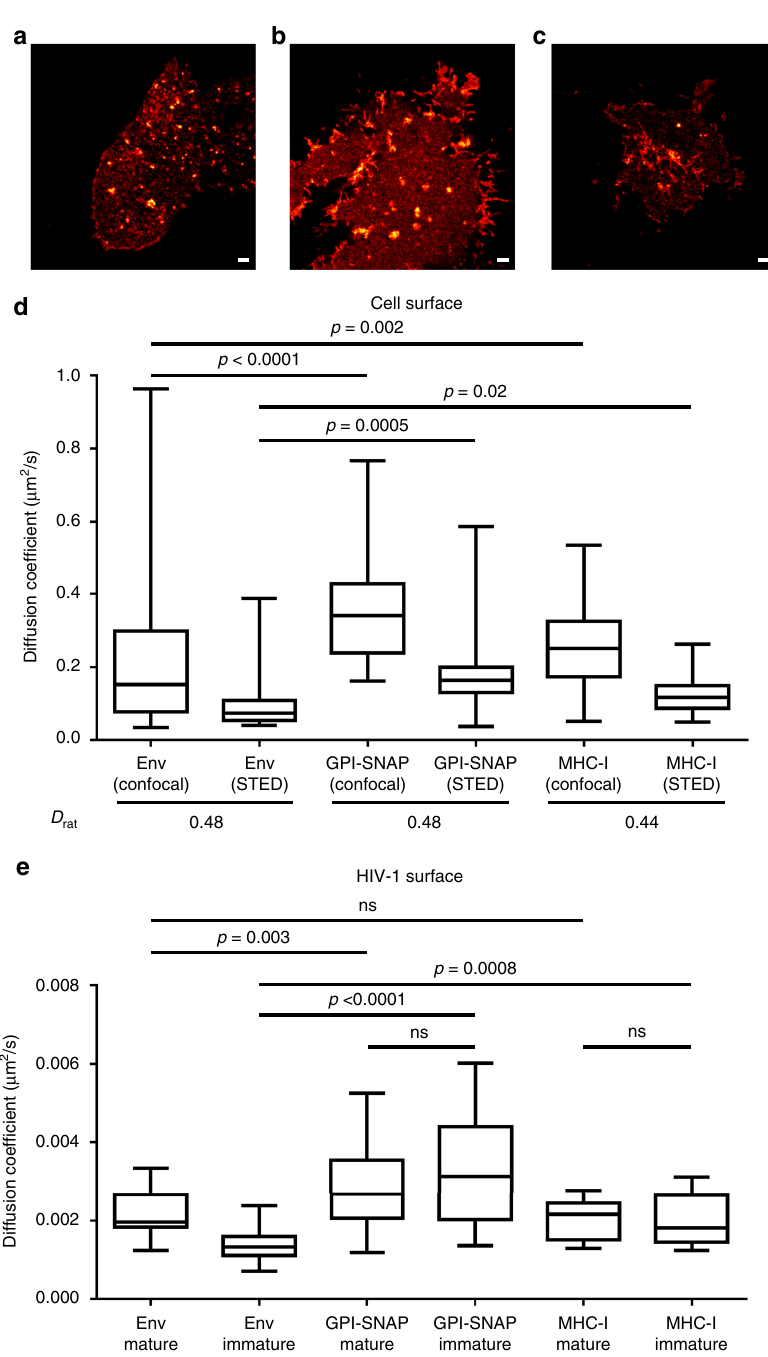
Fig. 4 Comparison of protein molecular dynamics in cell and virus membranes. a – c Live confocal images of 293T cells expressing Env a and GPI-SNAP b supplied in trans, and endogenous MHC-I c . Env and MHC-I were visualised by immunostaining and GPI-SNAP by fl uorescent SNAP tag substrate. Scale bars: 2 µ m. d Median diffusion coef fi cients ( D ) of Env, GPI-SNAP and MHC-I cell surface mobility were determined by confocal FCS ( D conf , observation spot diameter = 240 nm) and STED-FCS ( D STED , observation spot diameter = 55 nm) measurements from 10 cells each in three independent experiments. Results are shown in a box (IQR) and whisker (min/max) plot. Ratios D rat = D STED / D conf , given below the x -axis, indicate trapped diffusion characteristics for all proteins ( D rat < 1). The statistical signi fi cance was assessed by Wilcoxon rank-sum test. e D -values of Env, GPI-SNAP and MHC-I diffusion in mature and immature HIV-1 particles were determined by sSTED-FCS analysis of 50 particles each from two independent virus preparations. Results are shown in a box (IQR) and whisker (min/max) plot and the statistical signi fi cance was assessed by Wilcoxon rank-sum test membrane. This difference in diffusion between Env and other proteins may be due to the comparative protein size, effects of Fab for all proteins in the plasma membrane (Fig. 4d), which indicates immunolabelling as well as the presence of interacting proteins. trapped diffusion, that is, millisecond-long arrests at points of Diffusion coef fi cients obtained from confocal ( D conf , observa- interactions with more immobile structures or binding partners, tion spot 240 nm FWHM) and STED ( D STED , observation spot as previously observed for sphingolipids in cell membranes 14 . NATURE COMMUNICATIONS | 8: